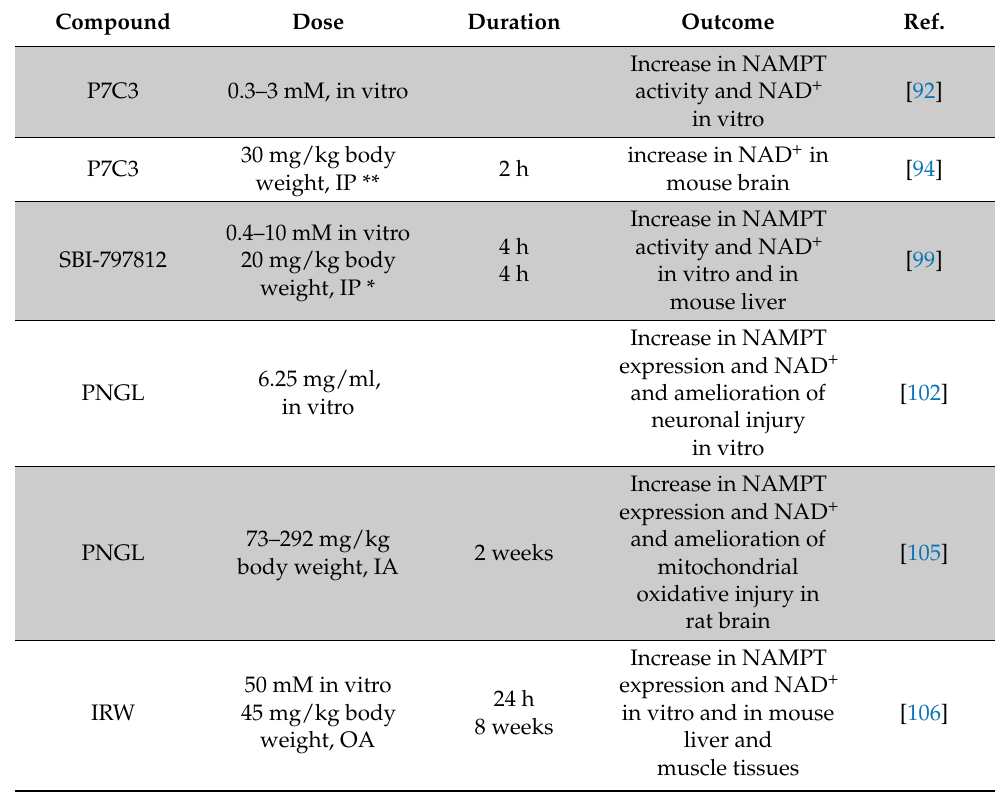
Table 2. Effects of compounds on NAMPT in vitro/in